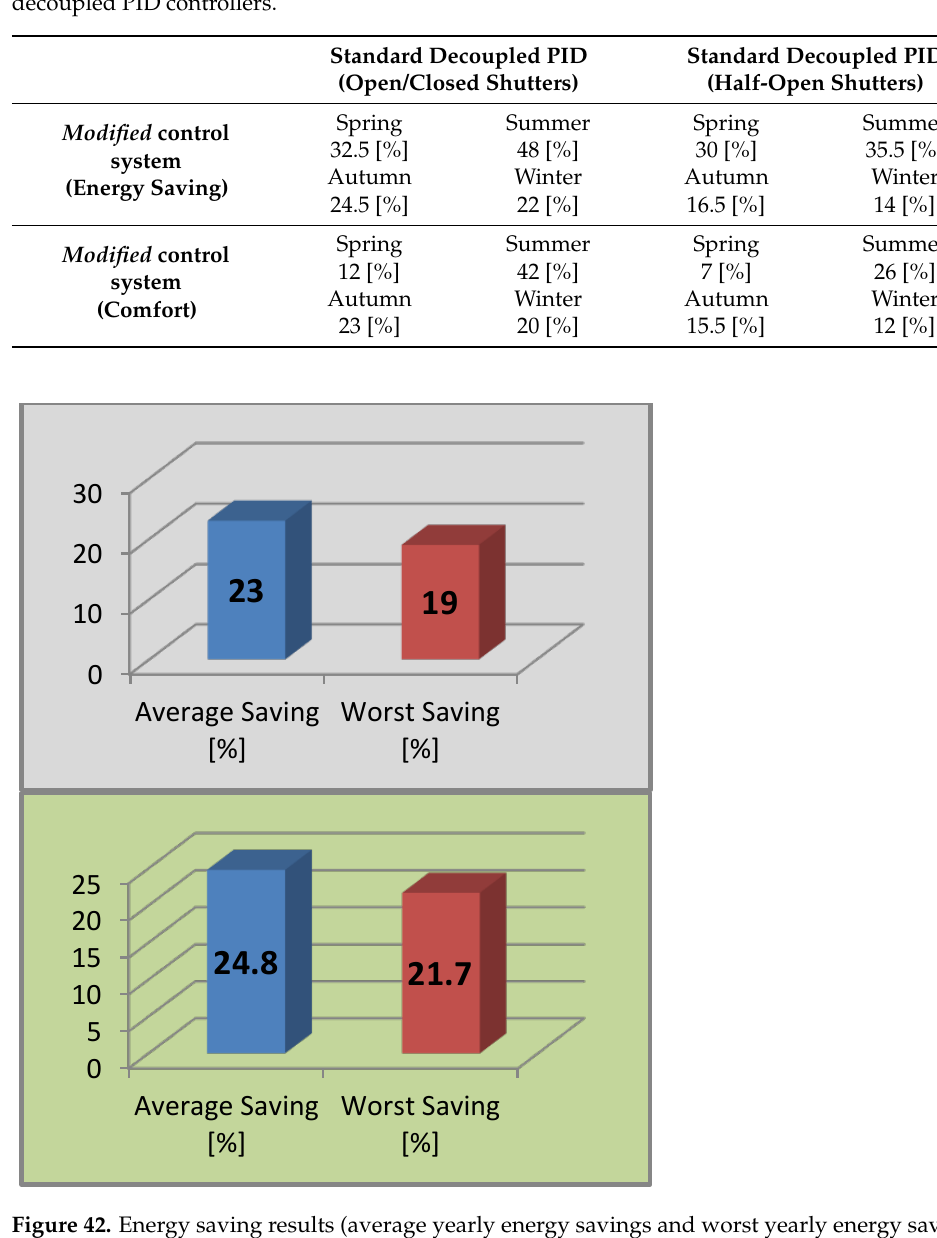
11 [%] Table 14. Energy saving results: comparison between the modified control system and the standard decoupled PID controllers. Standard Decoupled PID (Open/Closed Shutters) Standard Decoupled PID (Half-Open Shutters) Modified control system